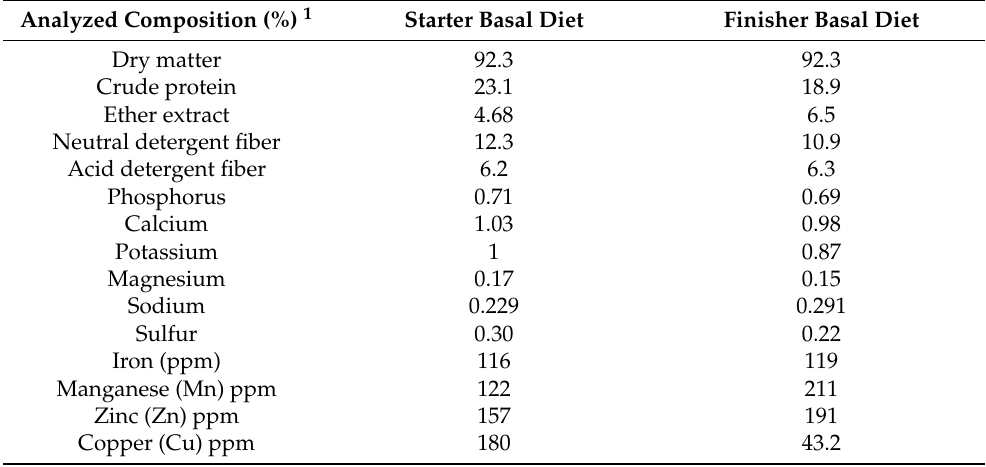
Table 2. Analyzed composition (% as dry matter) of the experimental basal diet.